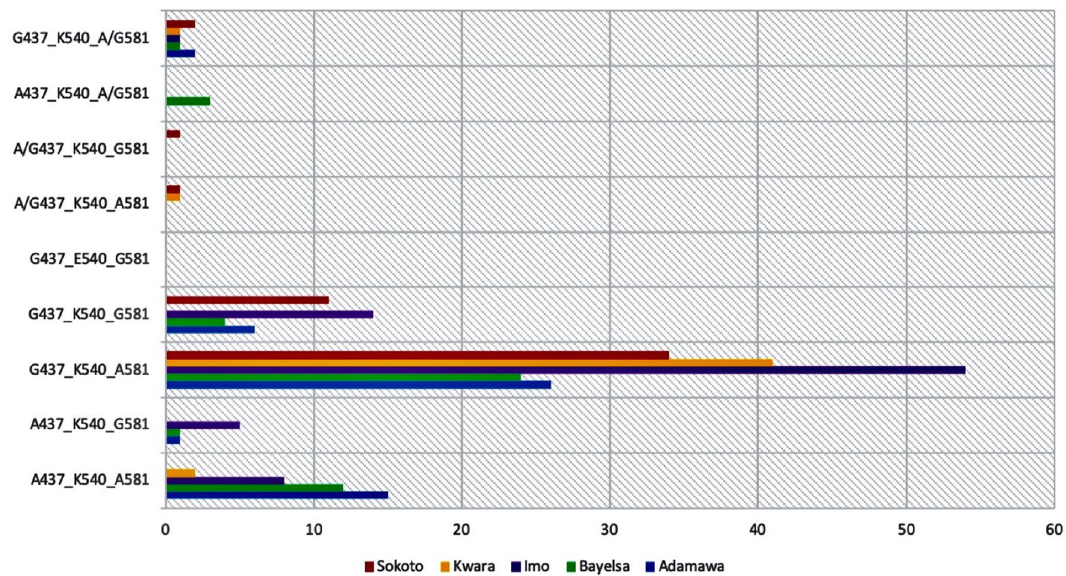
Figure 3. Bar chart showing the distribution of dhps haplotypes in five Nigerian States. Red colour represents Sokoto State, Yellow represents Kwara State, Purple represents Imo State, Green represents Bayelsa State and Blue represents Adamawa State. The single mutant haplotype G 437 K 540 A 581 was the most distributed in all five Double mutant R 59 N 108 haplotype was only recorded in two children from Kwara and Sokoto States (Northern States) (Fig. 2). Parasites harbouring the dhps double mutant G 437 G 581 , single mutant G 437 and single mutant G 581 haplotypes were observed in 13.7%, 66.1% and 2.6% respectively of the 271 children considered (Fig. 3). There was no triple and quadruple dhps mutant haplotype because none of the isolates harboured mutant allele of dhps 540. There was no difference in the distribution of the double mutant G 437 G 581 and single mutant G 437 haplotypes in the Northern and Southern States (p > 0.05). Prevalence of combined dhps and dhfr haplotypes. The prevalence of different alleles on dhfr and dhps genes when combined as single mutant haplotype ( dhfr N 108 ), double mutant haplotype ( dhfr R 59 N 108 ), triple mutant haplotype ( dhfr I